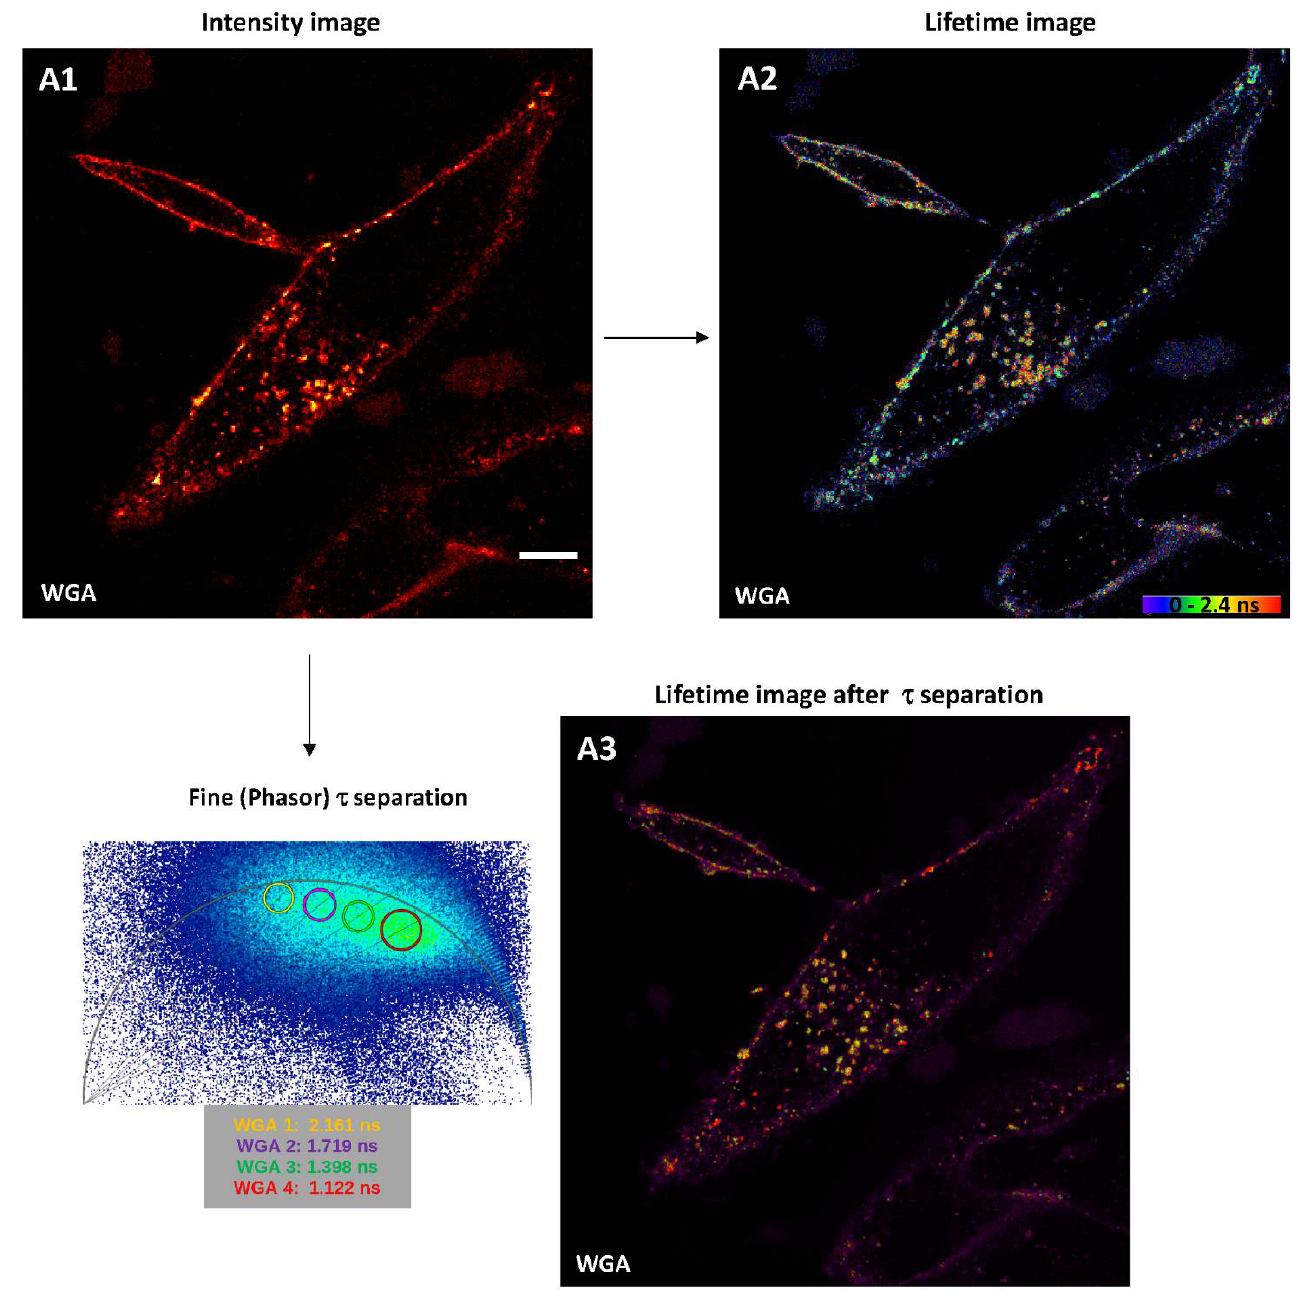
Figure 6. Input of fitting and phasor plot analyses in fluorescence lifetime microscopy (FLIM) of living H28 cells labeled with Alexa Fluor 633-WGA. ( A1 ) Confocal imaging (signal intensity) of Alexa Fluor 633-WGA-labeled H28 cells (ex 633 nm, 3%; em 640–760 nm, HyD-X). FLIM ( A2 ) and fine τ separation ( A3 ) images of Alexa Fluor 633-WGA-labeled H28 cells. Scale bars 10 µm.